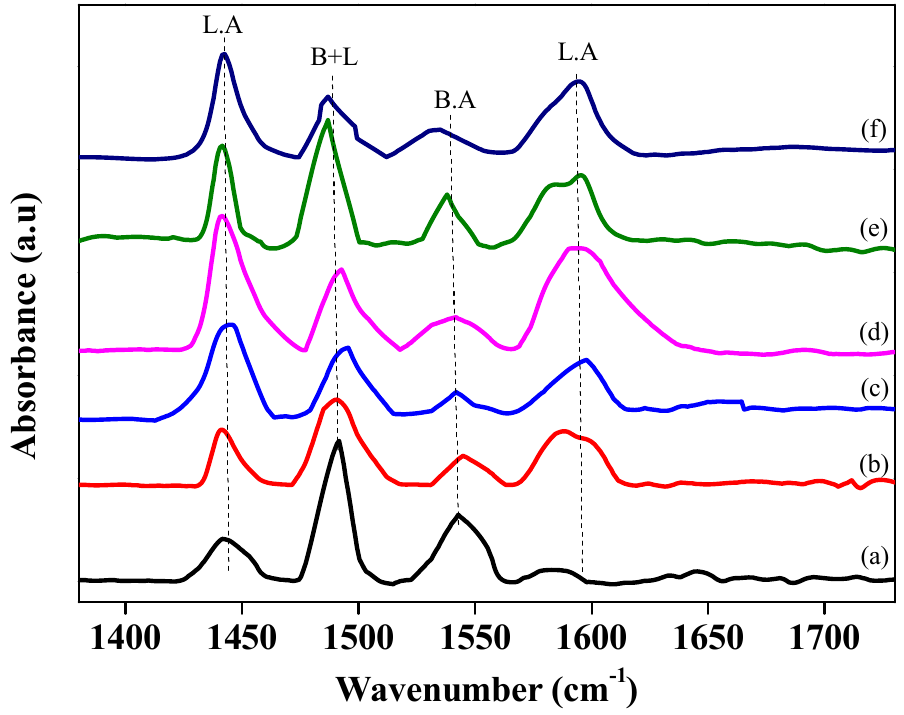
Figure 8. Pyridine-adsorbed IR spectra of hierarchical zeolite samples (a) Ni-Z50, (b) Ni- HZ-0.2 M,